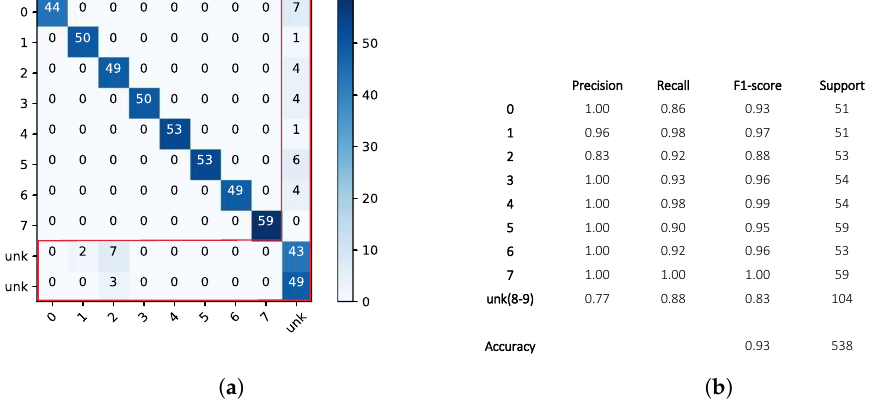
Figure 14. The results of the proposed PS-Openmax approach: ( a ) the confusion matrix and ( b ) the corresponding classification